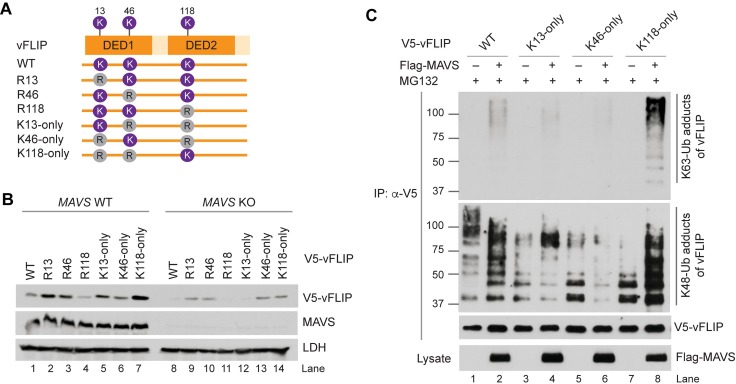
MAVS promotes K63-linked polyubiquitination at lysine 118 of vFLIP.(A) Diagram of the single and combined vFLIP mutations in lysine residues at positions 13, 46, and 118. (B) Immunoblots of extracts from WT and MAVS KO 293T cells transfected for 24 h with expression vectors for WT V5-vFLIP and the indicated mutants of V5-vFLIP. (C) In vivo vFLIP ubiquitination assays using 293T cells transfected with vectors expressing WT or lysine-mutated V5-vFLIP with or without Flag-MAVS in the presence of 10 μM MG-132 for 24 h.